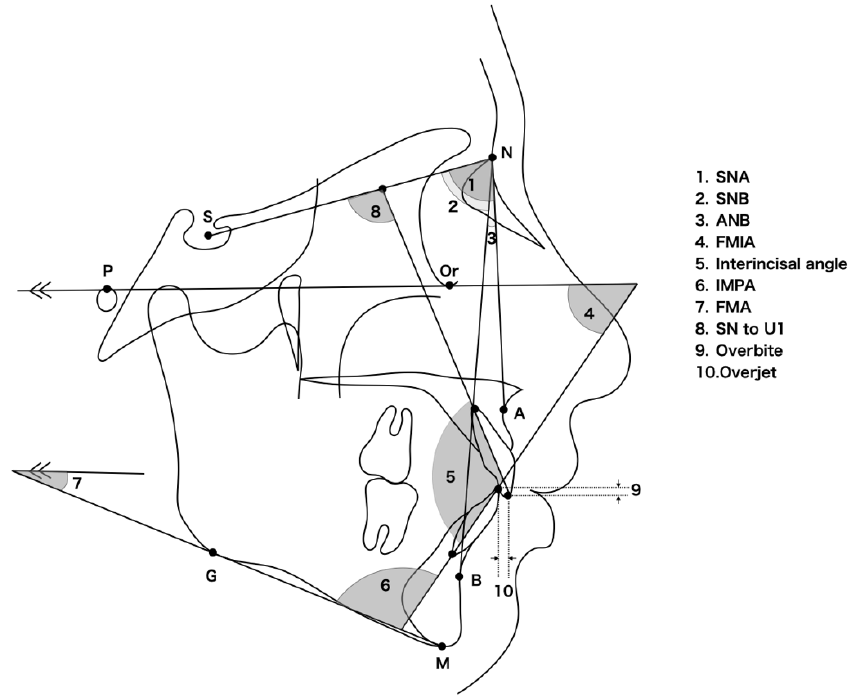
Figure 2. Cephalometric measurements: 1. SNA (degrees), 2. SNB (degrees), 3. ANB (degrees), 4. FMIA (degrees), 5. Interincisal angle (degrees), 6. IMPA (degrees), 7. FMA (degrees), 8. U1—SN (degrees), 9. Overbite (mm), 10. Overjet (mm).